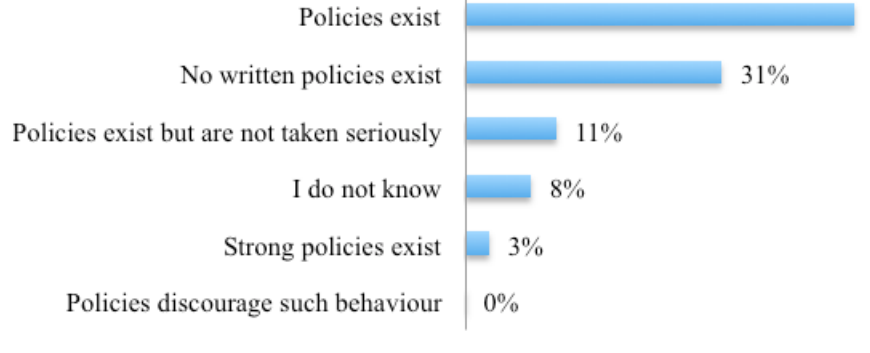
Figure 3. Opinions